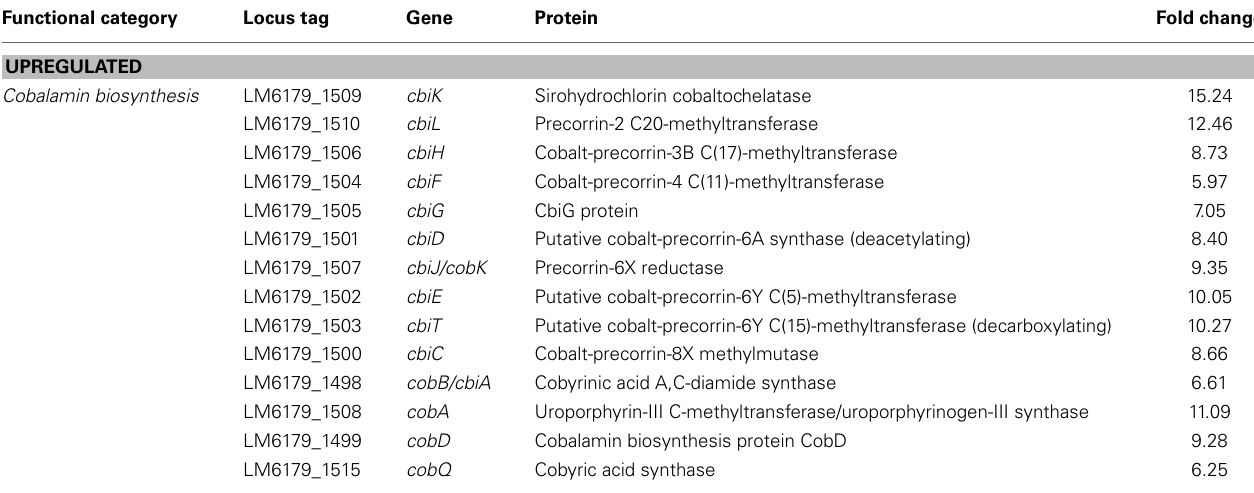
Table 4 | Cobalamin biosynthesis genes which change in regulation following exposure of strain 6179 to BZT. Functional category Locus tag Gene Protein UPREGULATED Cobalamin